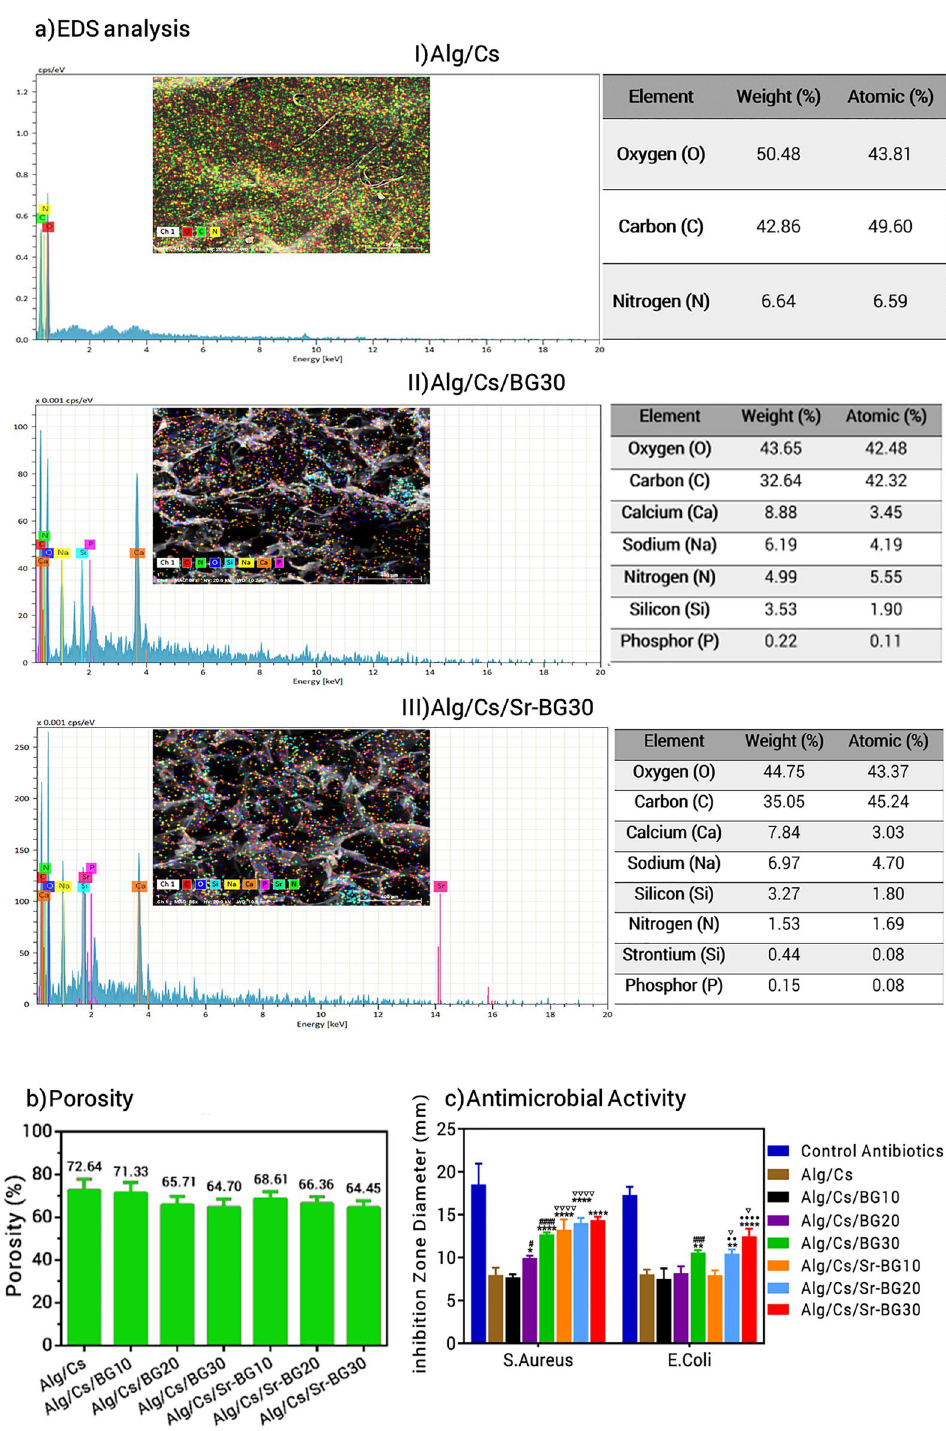
Figure 4. EDS analysis, Porosity and Antimicrobial activity of scaffolds. ( a ) EDS analysis: (I) Alg/Cs, (II) Alg/ Cs/BG30 and (III) Alg/Cs/Sr-BG30. ( b ) Porosity, ( c ) Antibacterial activity. Significant difference with Alg/Cs group at p < 0.05 (*), p < 0.01 (**), p < 0.0001 (****). Significant difference with Alg/Cs/BG10 group at p < 0.05 ( # ), p < 0.001 ( ### ), p < 0.0001 ( #### ). Significant difference with Alg/Cs/Sr-BG10 group at p < 0.01 ( ·· ), p < 0.0001 ( ···· ). Significant difference between Alg/Cs/BG and Alg/Cs/Sr-BG groups at p < 0.05 ( ⛛ ) , p < 0.05 ( ⛛⛛⛛⛛